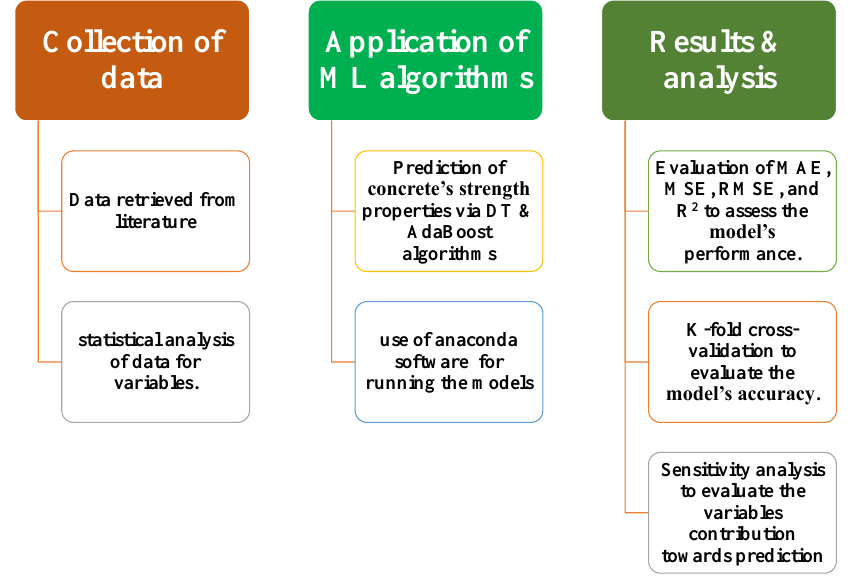
Figure 2. Flow chart of the research program.